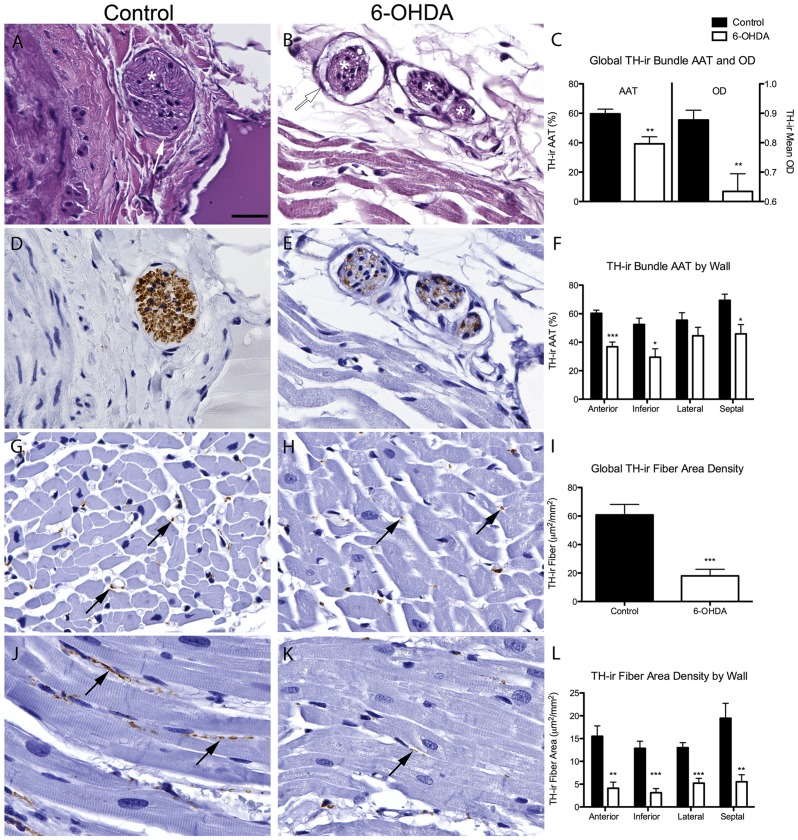
6-OHDA-treated monkeys have reduced TH-ir in cardiac nerve bundles and fibers.(A,B) Microphotographs of H&E stained nerve bundles identified as a collection of nerve fibers (white asterisk) and intact epineurium indicated by white arrows. (C) Global TH-ir in cardiac nerve bundle was reduced for both AAT (t(8) = 3.508, P = 0.008) and OD quantification (t(8) = 3.403, P = 0.009) in 6-OHDA compared to control animals. (D,E) Microphotographs of TH-ir in matching nerve bundles. (F) Regional wall quantification showed reduced AAT of TH-ir in anterior (t(8) = 5.913, P<0.0001), inferior (t(8) = 3.096, P = 0.015), and septal (t(8) = 3.009, P = 0.017) walls in 6-OHDA-treated monkeys compared to controls. In the control group there were also significant differences in OD quantification of TH (F(3,16) = 5.213, P = 0.011) with more TH-ir in the septal wall compared to the lateral (P = 0.043) and inferior walls (P = 0.12) (post hoc Bonferroni multiple comparisons analysis; not shown). (G,H,J,K) Microphotographs of cardiac TH positive fibers in either transverse (G,H) or longitudinal orientation (J,K) in control and 6-OHDA monkeys; black arrows indicate TH-ir fibers. (I,L) TH-ir fiber area density was significantly reduced in 6-OHDA compared to control animals for global (I) analysis (t(8) = 4.934, P = 0.001) and between all walls of the left ventricle (L) including the anterior (t(8) = 4.324, P = 0.003), inferior (t(8) = 5.37, P = 0.001), lateral (t(8) = 5.081,P = 0.001) and septal walls (t(8) = 3.866, P = 0.005). Scale bar  = 25 µm. *P<0.05, **P<0.01, ***P<0.001. AAT, area above threshold; OD, optical density; TH, tyrosine hydroxylase.